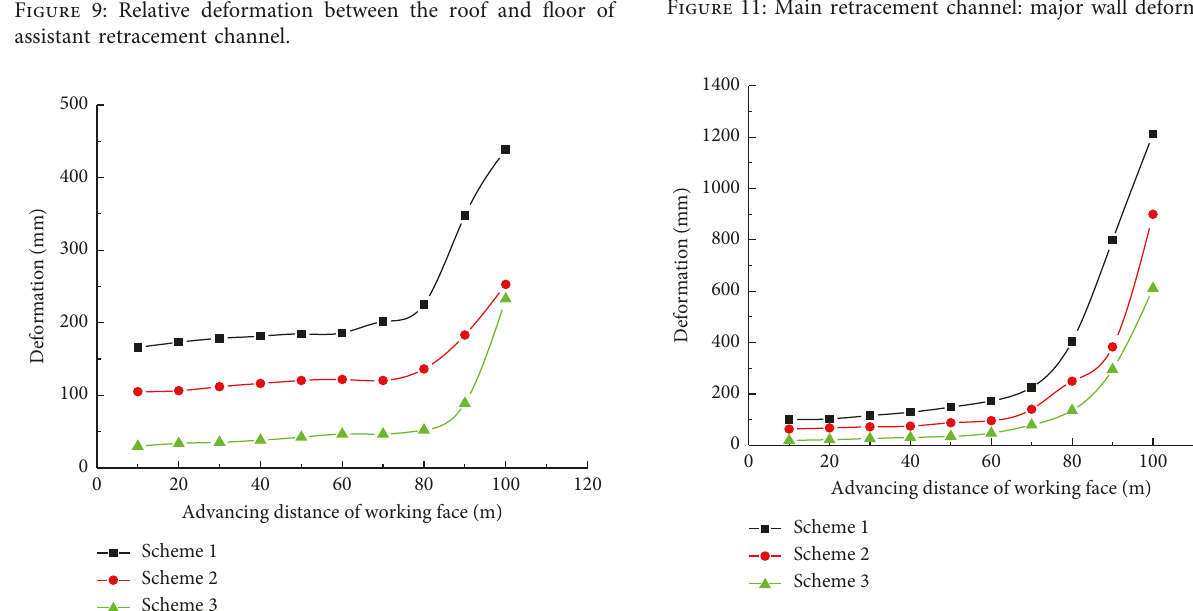
Figure 12: Relative deformation between the roof and floor of main retracement channel.